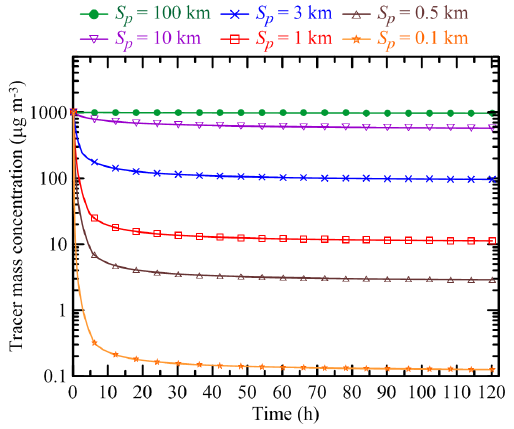
Figure 1. Simulated evolution of the mass concentration of an inert tracer for different values of the initial plume size, S p . The simula- tions were done with an initial tracer concentration of 1000µgm 3